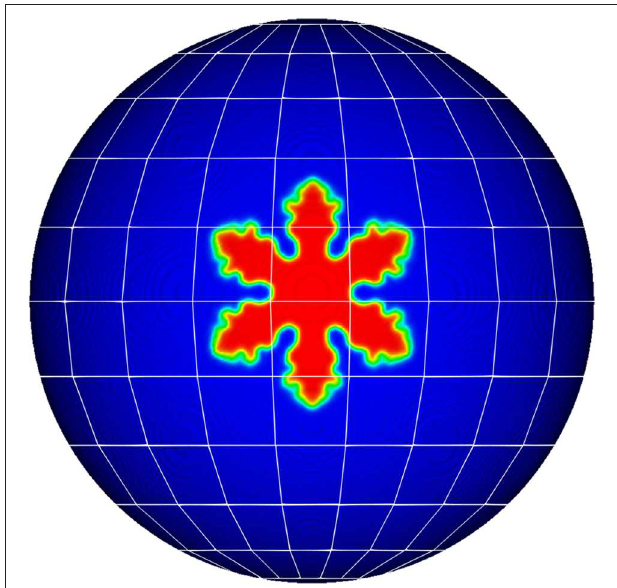
FIGURE 1 | Scheme of the computational approach used to study dendritic growth on spherical substrates. The evolution equations are solved in spherical coordinates. The number of grid-points are adjusted to obtain equivalent grids on substrates of different curvature.